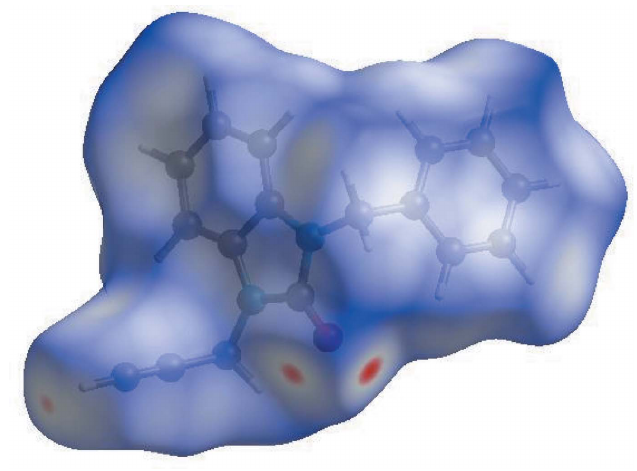
Figure 4 View of the three-dimensional Hirshfeld surface of the title compound plotted over d norm in the range (cid:4) 0.1150 to 1.2702 a.u.